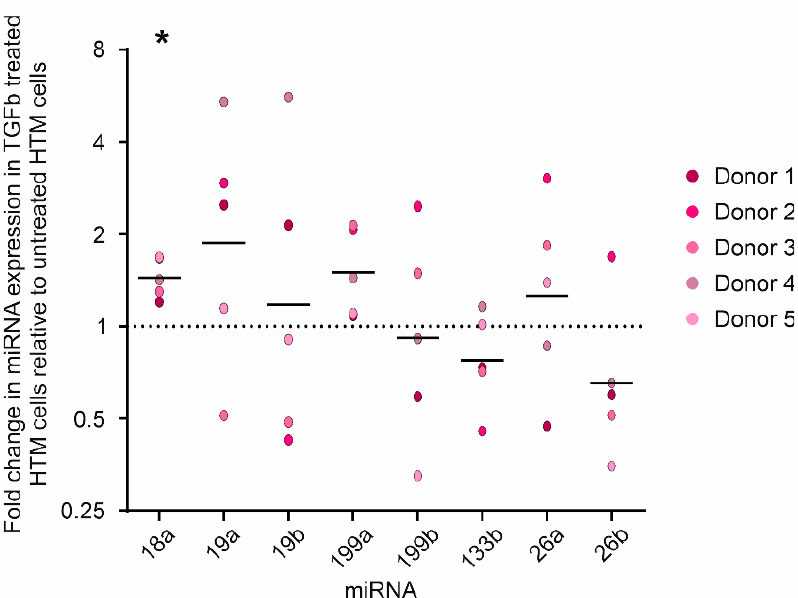
Figure 1. miR-18a-5p expression increases in human TM cells treated with TGF β 2. Fold change in miRNA expression relative to untreated human TM cells, normalised to the geometric mean of SNORD61 and SNORD68. Individual values for donors 1 to 5 are shown, with the mean ΔΔ Ct shown as a bar. The line at y = 1 represents the level of expression in untreated cells. * p = 0.0006, n = 5, Student’s t -test with Holm – Sidak correction for multiple comparisons.